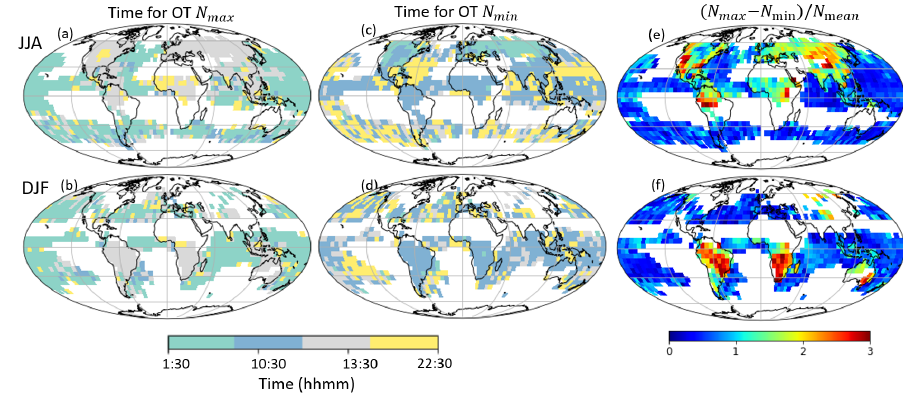
Figure 10. Panels (a) – (d) are for the times when maximum and minimum OT occurrences occur across the four observation times. Panels (e) – (f) are for the diurnal intensity of OT occurrences, which are defined as the difference in the maximum and minimum OT occurrences that is normalized by the mean. Only when the minimum OT occurrences > 10 in each 5 ◦ × 5 ◦ grid are the data shown.